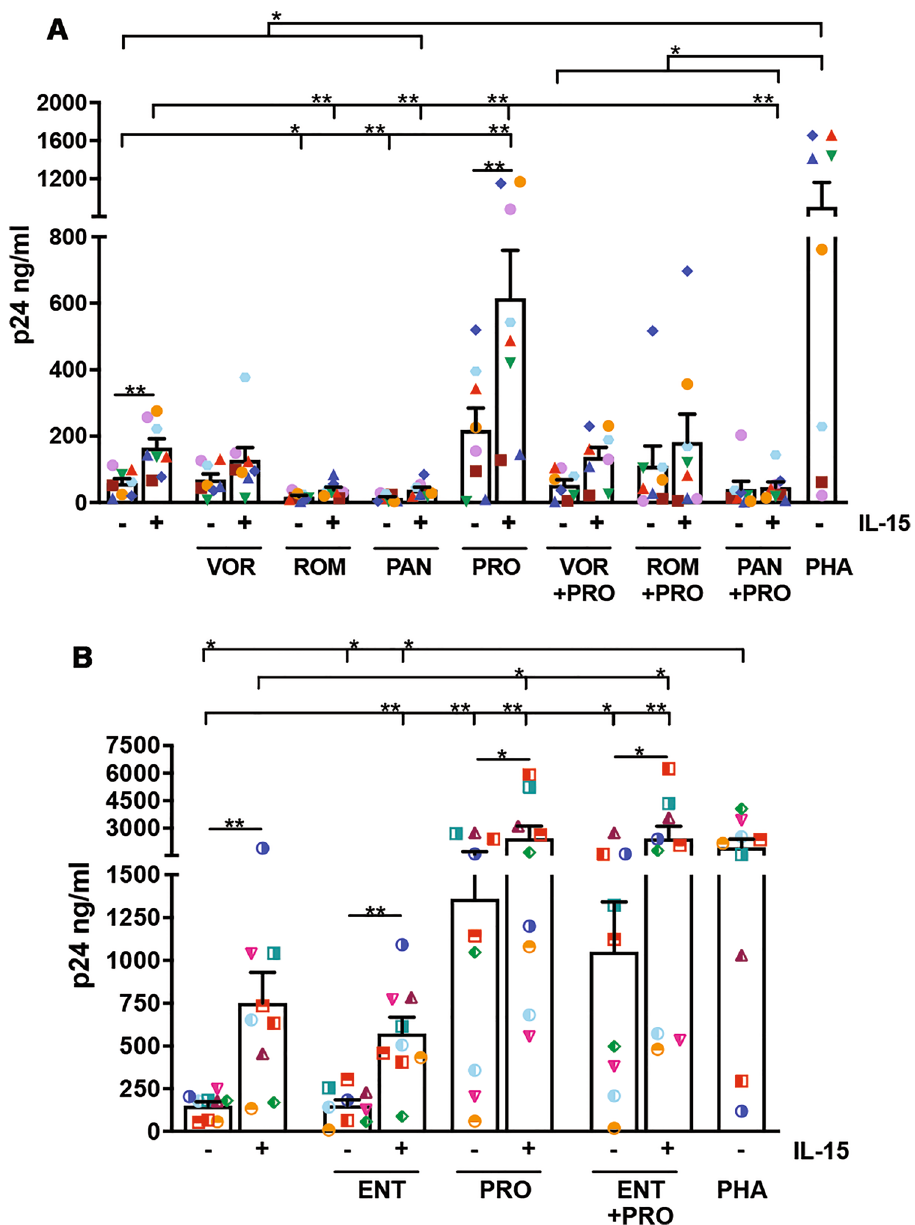
Figure 4. Effect of IL-15 addition to HDACi, PRO, and HDACi + PRO on reactivation of HIV in latently infected CD4 + T cells. Latent HIV infection was established in resting CD4 + T cells derived from healthy donors as described in Materials and Methods. Three days post-infection cells were collected and replaced in culture in the following conditions: medium alone or supplemented with IL-15, HDACi or PRO alone or in HDACi + PRO combinations with or without addition of IL-15, or PHA. After 48 h cells were washed and seeded at 2 × 10 6 /ml in the same initial conditions. Five days later, p24 released in the culture medium was analyzed by ELISA. Eight and nine different donors (each represented with one symbol) were tested for combinations of pan-HDACi ( A ) and ENT ( B ), respectively. Bars represent mean ± SEM. Comparisons were performed using paired Wilcoxon or t -test versus unstimulated control, IL-15 alone, LRA without IL-15, or PHA. * p < 0.05; ** p <